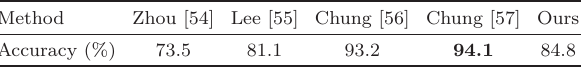
Fig. 13 Phrase recognition accuracies for each subject from the OuluVS2 phrase dataset. Table 5 Phrase recognition accuracies on the OuluVS2 dataset